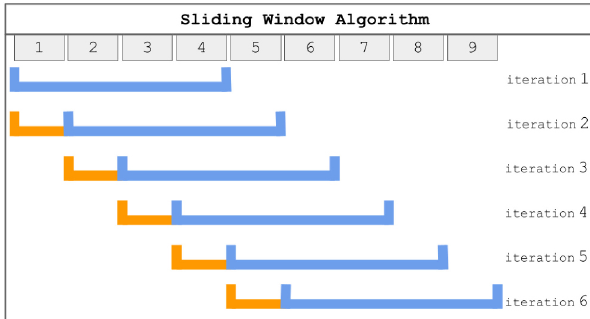
Fig. 4 Sliding window algorithm for an image sequence of 9 frames (gray) with window size 4. Frames underlined in blue lie inside the sliding window, currently being optimized. Frames underlined in orange are not optimized (body model parameters set to constant) but influence the optimization, as the temporal loss term (Eq. (7)) is calculated for all frames in the window except the